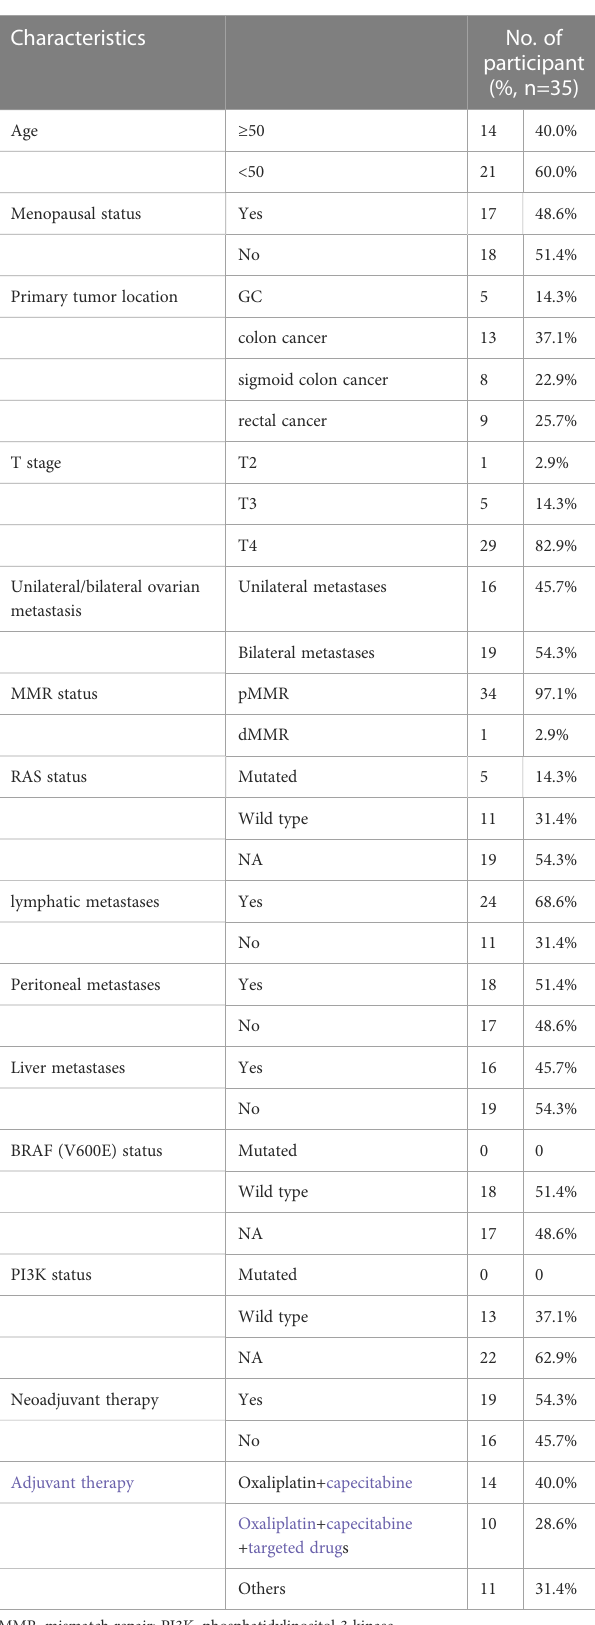
TABLE 1 Summary of patients ’